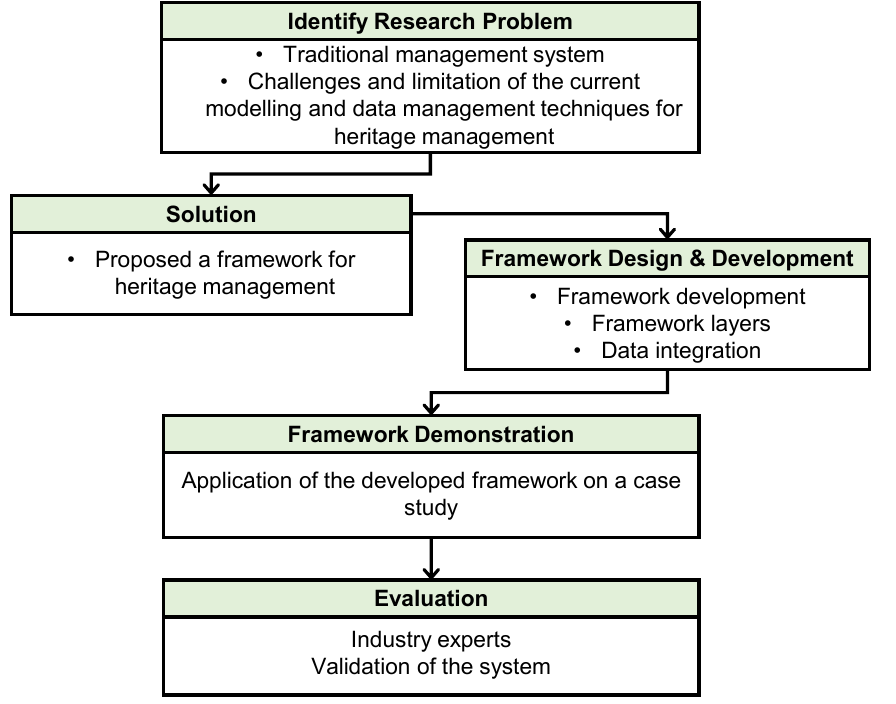
Figure 2. Research methodology.